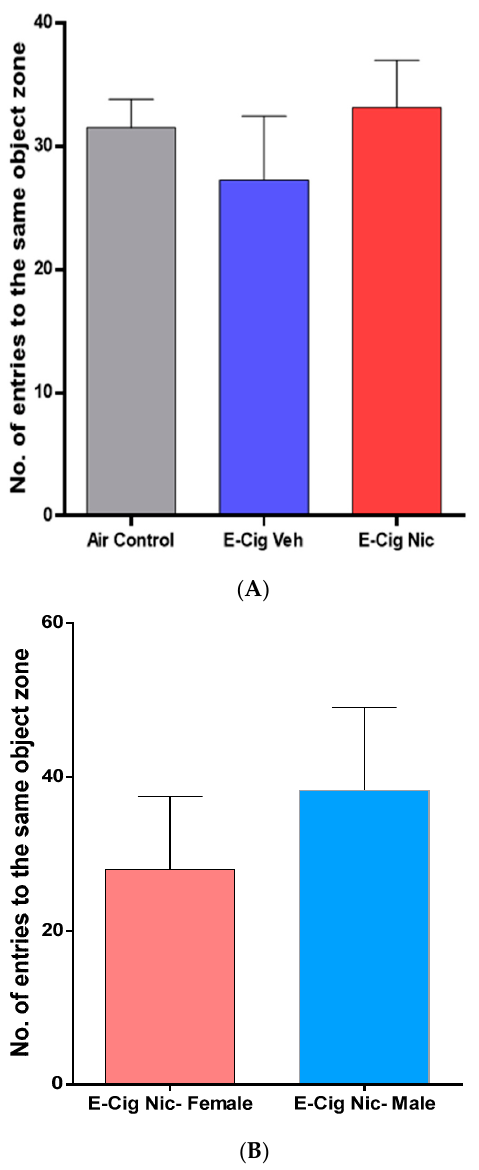
Figure 3. Recognition memory behaviors following four-week inhalation of e-cigarette vapors containing nicotine. ( A ) No. of entries into the same object zone (n = 8/group, 4F and 4M). One-way analysis of variance (ANOVA) did not show significant differences between the three groups. ( B ) No. of entries into the same object zone between male and female mice in the E-cig Nic group (n = 4/group). Unpaired t test also did not reveal any significant changes in the same zone number entries between male and female of E-cig Nic group. Data are presented as mean ± SEM. E-cig, electronic cigarette; E-cig Veh, electronic cigarette with vehicle only; E-cig Nic, electronic cigarette with nicotine; F, female; M, male.